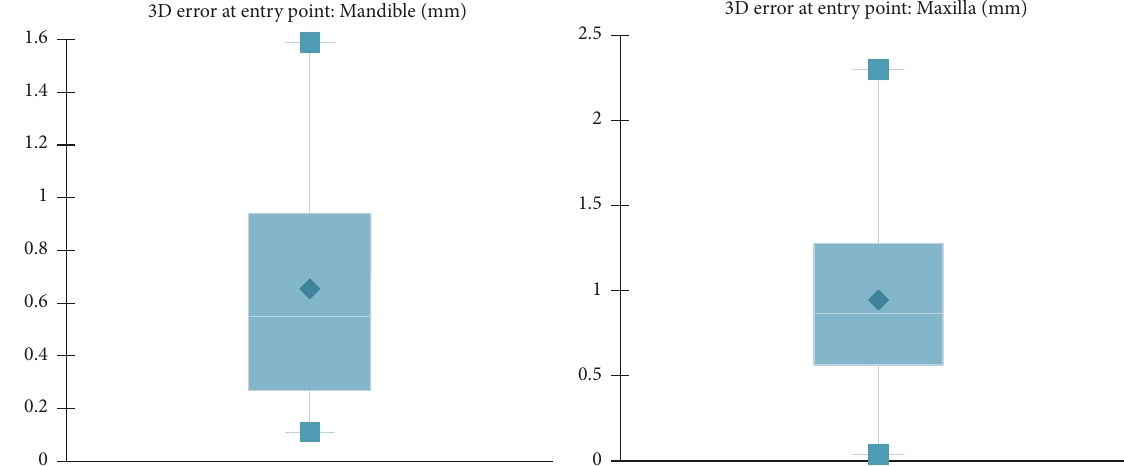
Figure 9: Mean 3D error at entry point, measured at the center of the implant in mandible and maxilla.